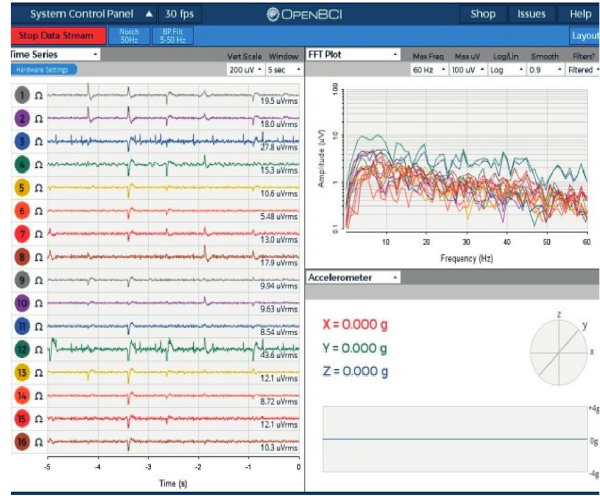
Figure 8: The EEG of push action idea in the static